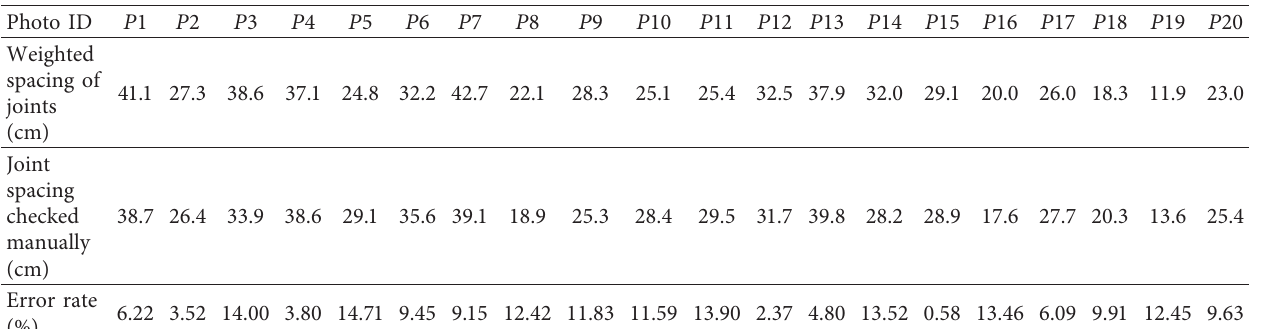
Table 3: Manual review of crack